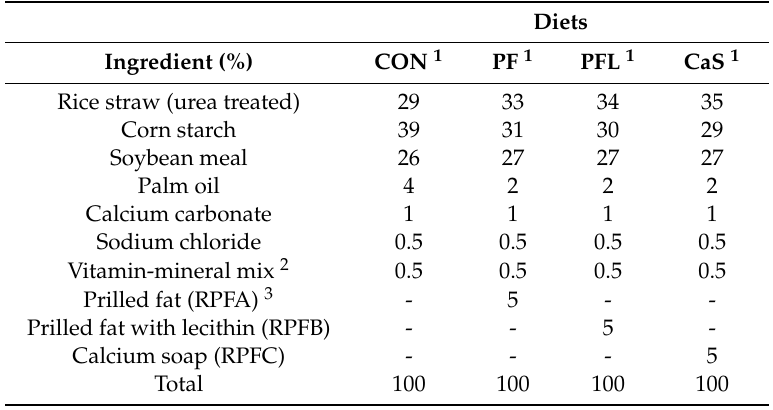
Table 2. Ingredients, chemical and fatty acid composition of experimental